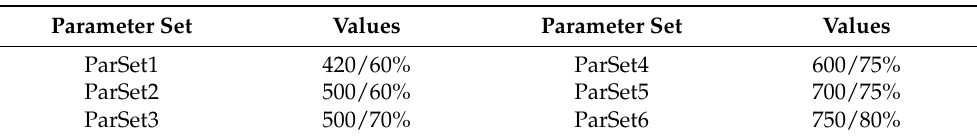
Table 5. Batched electrical parameter sets for coil. Two core parameters: turn number of coil windings, duty of PWM